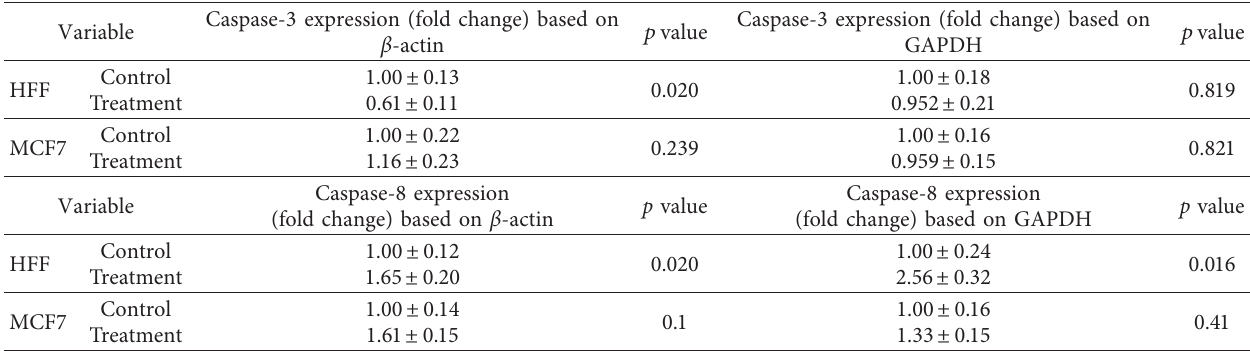
Table 3: The t -test was performed for the fold change values for caspase-3 and caspase-8 gene expression analysis in ZnO-NP-treated cells. Caspase-3 expression (fold change) based on Variable